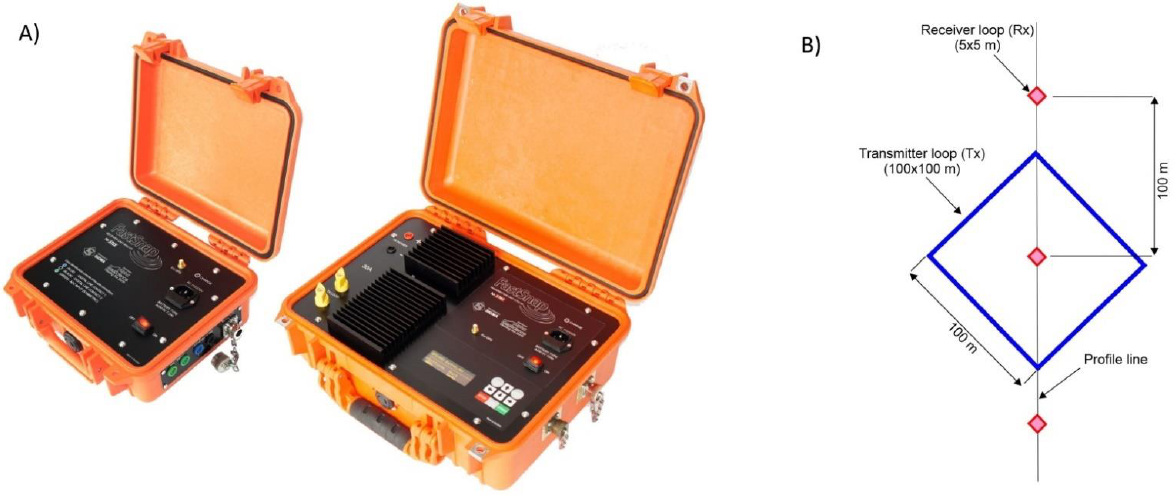
Figure 2. ( A ): Fastsnap instruments; ( B ): Three-channel sTEM configuration.